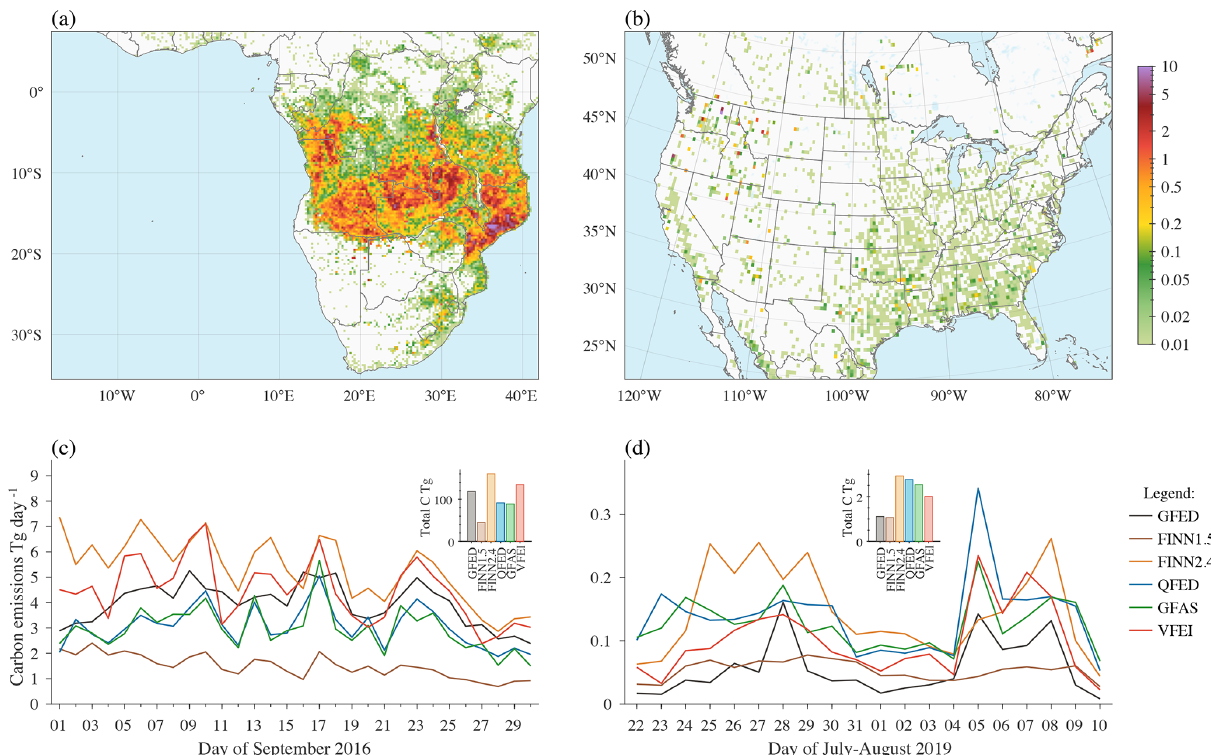
Figure 5. (a, b) Total carbon emissions (Tg) for the period of (a) September 2016 and (b) between 20 July and 11 August 2019 from VFEI in each model simulation. (c, d) Time series of daily carbon emissions (Tgd − 1 ) comparing VFEI to other inventories over the domains shown at the top. Small plots represent the total carbon emitted in each region during their